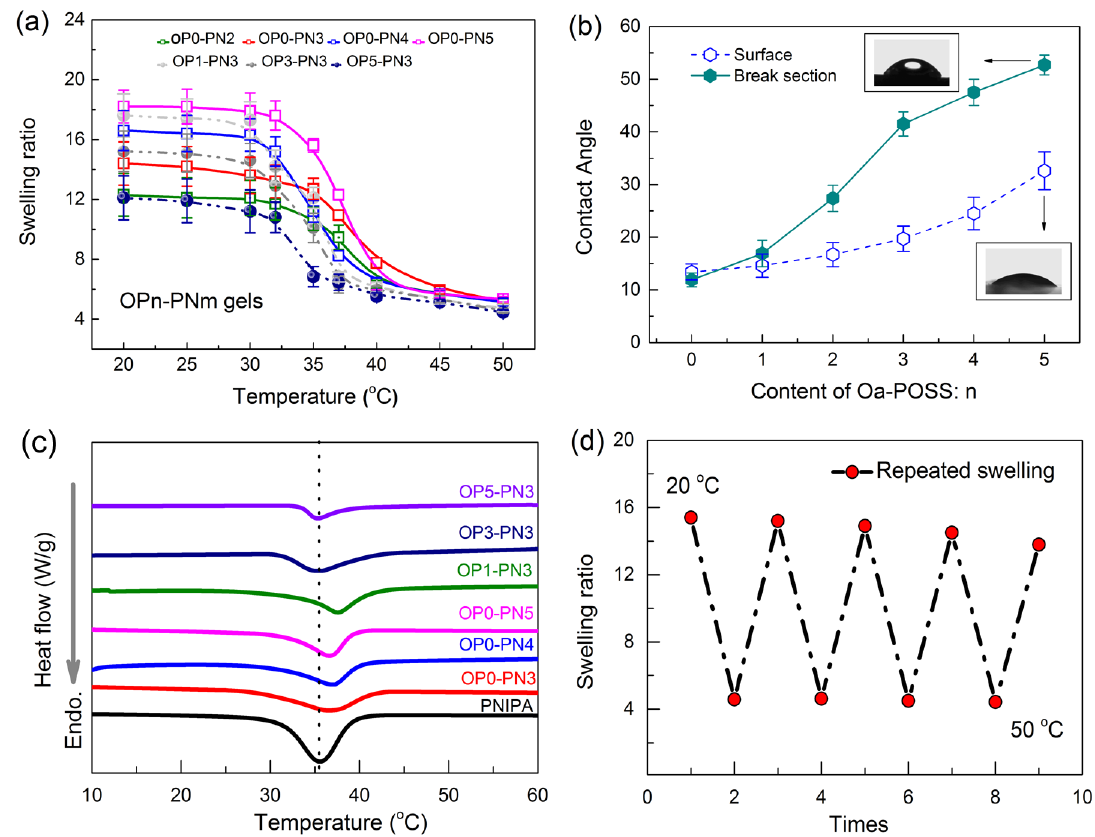
Figure 5. Swelling properties of OPn-PNm gels: ( a ) equilibrium swelling ratio of OPn-PNm in pure water at different temperatures; ( b ) water contact angle of OPn-PN3 gels; ( c ) differential scanning calorimetry (DSC) curves of OP0-PNm and OPn-PN3 gels; ( d ) repeated swelling ability of OP3-PN3 gels. Gels were tested until reaching equilibrium in 20 and 50 °C water alternatively.